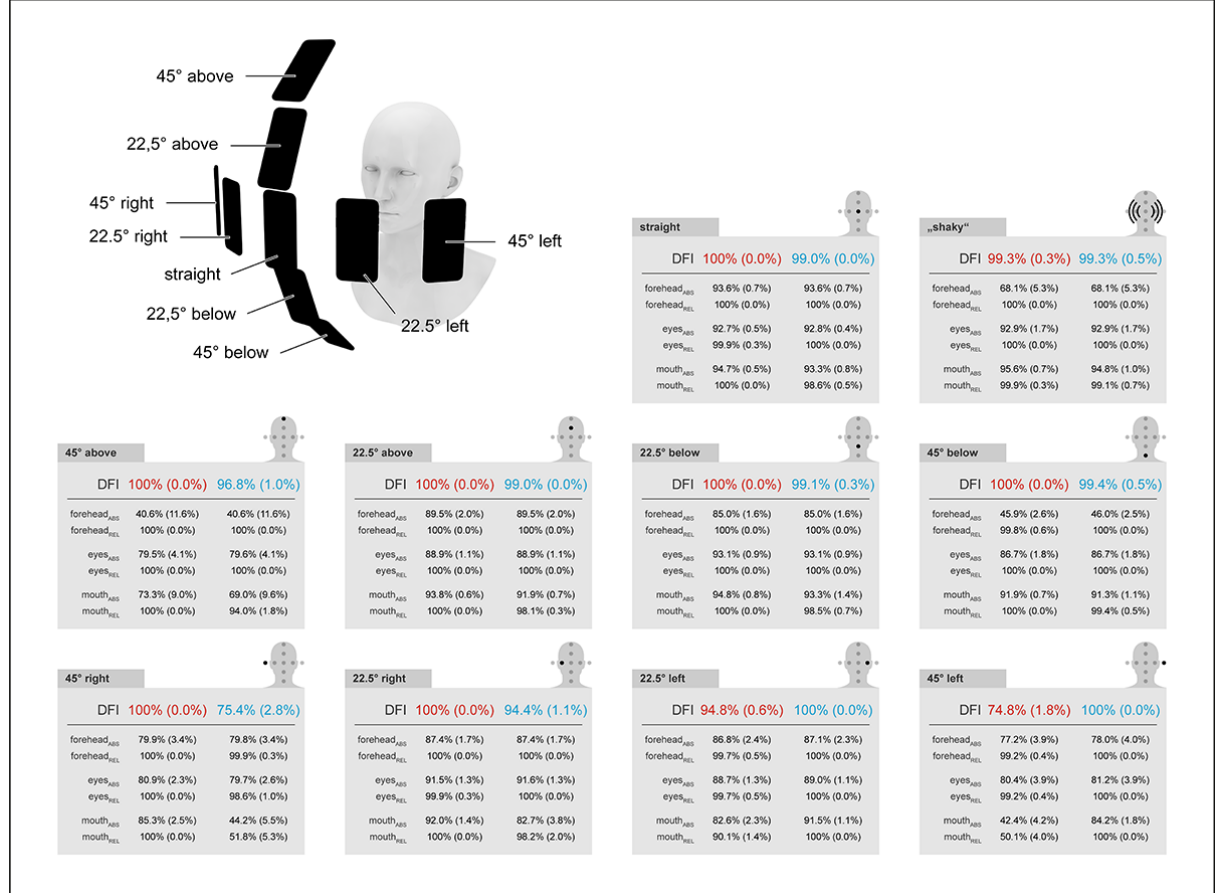
Figure 8. To simulate unfavorable measurement conditions, 10 measurements (mean [SD] shown) were carried out on a (healthy) test person at different angles relative to the median of the head at eye level and at 37.5 cm, with tripods to fix the position of the smartphone and the head of the test person; in addition, a measurement was made with deliberately shaky hand movements and occasionally leaving the face out of the camera's field of